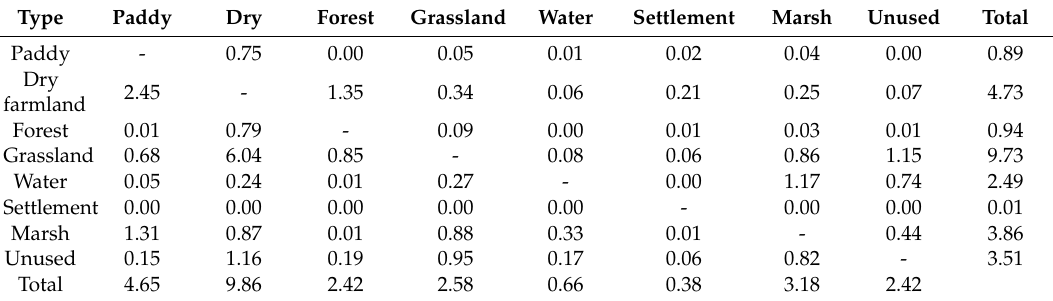
Table 7. Cumulative transition probability of di ff erent land-use change types (unit: